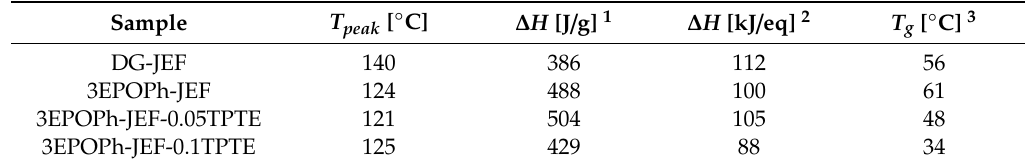
Table 2. Calorimetric data of the curing process of the formulations